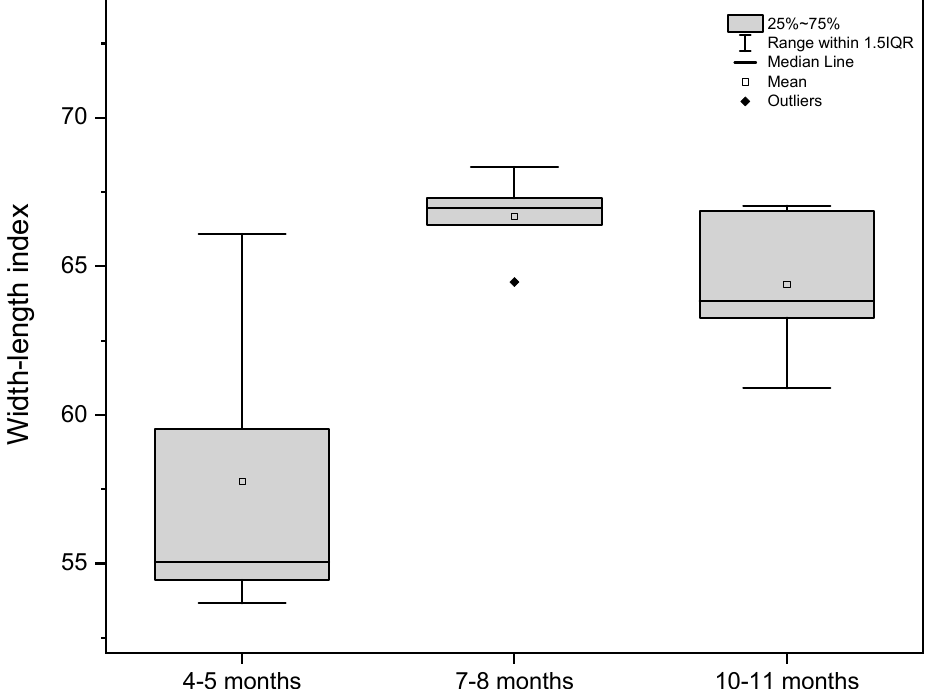
Figure 7. Width-length index values in the fetal period (4th to 11th month of gestation).